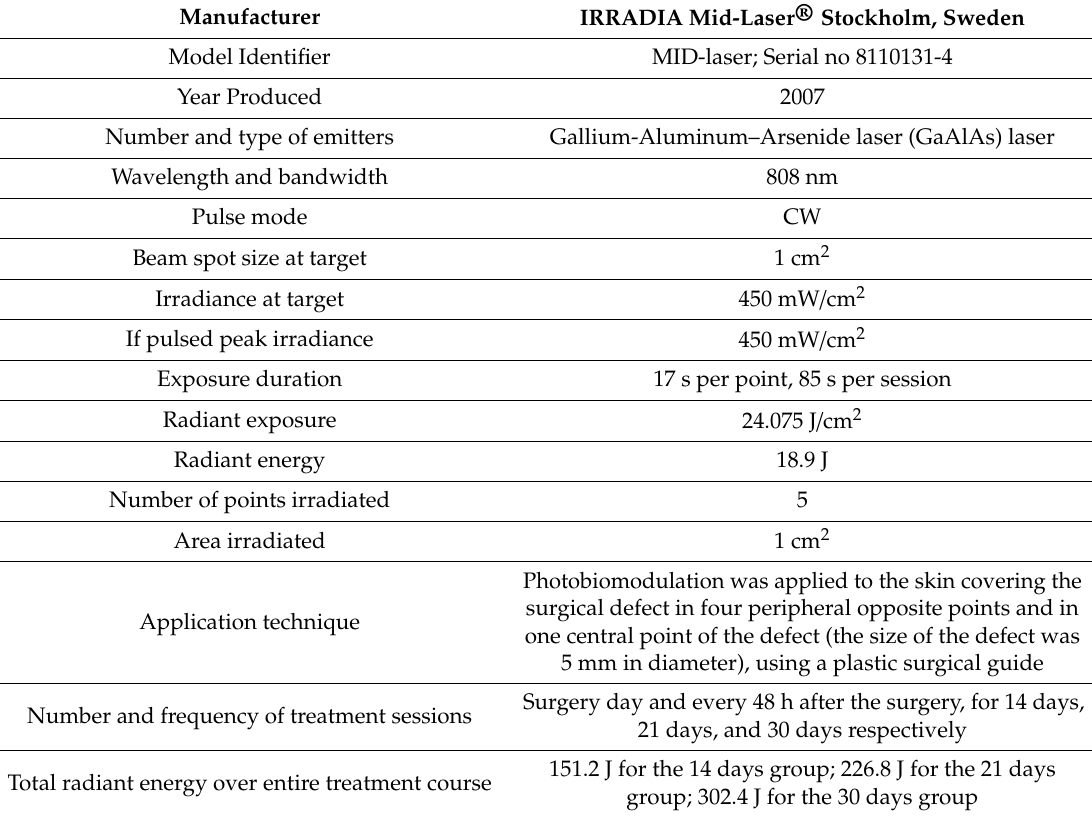
Table 1. Photobiomodulation parameters in the experimental